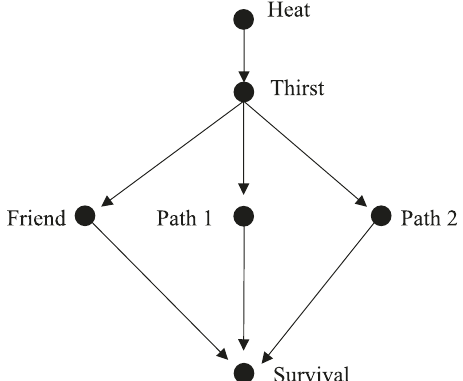
Fig. 2 The man has two paths in front of him, one of which leads to a river, thus to survival. A friend who often passes by the forest could help him choose the right path — or even give him water; therefore, the best choice would be to wait for him. However, the climate gets hotter and